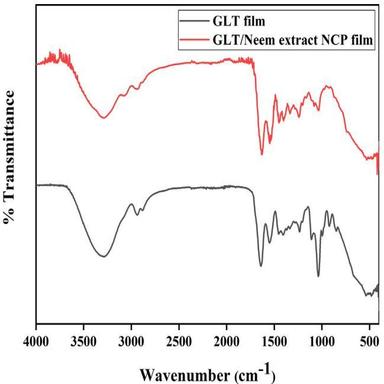
FTIR analysis of GLT and GLT/Neem extract NCP film.